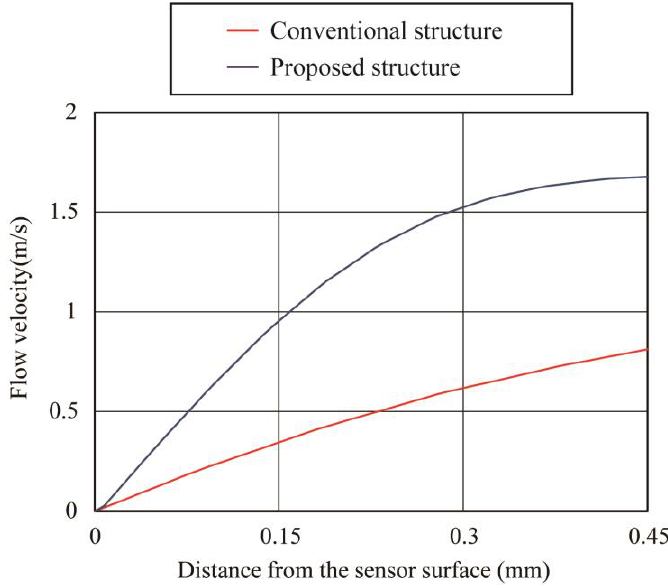
Figure 4. Flow velocity versus distance from sensor surface for conventional and proposed struc- tures. The proposed structure with the sensor placed in the center of the tube has a large slope of flow velocity change.